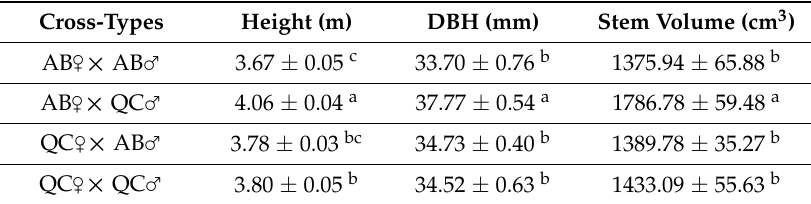
Table 2. Mean height ( ± SE), diameter at breast height (DBH), and stem volume at age six from two Alberta sites (AB1 and AB2) for the four cross-types as indicated by Alberta (AB) and Quebec (QC) with the female parent listed first. Significant differences between cross-type means are indicated by different